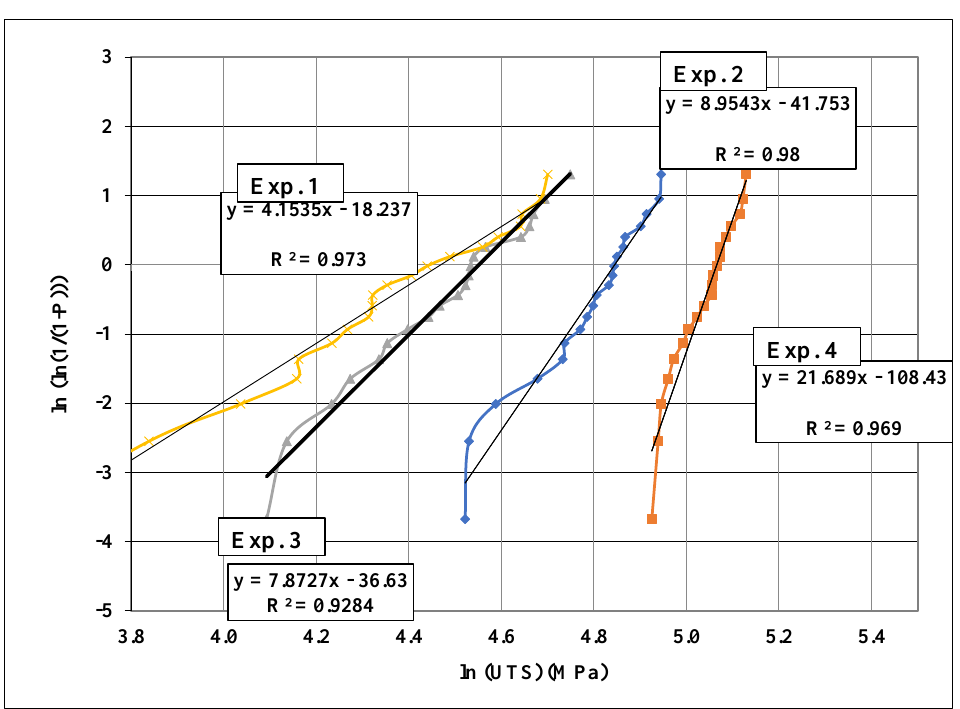
Figure 2. Weibull distribution of UTS of Al – 7 Si – 0.3 Mg alloy for different experiments itemised in Table 1.